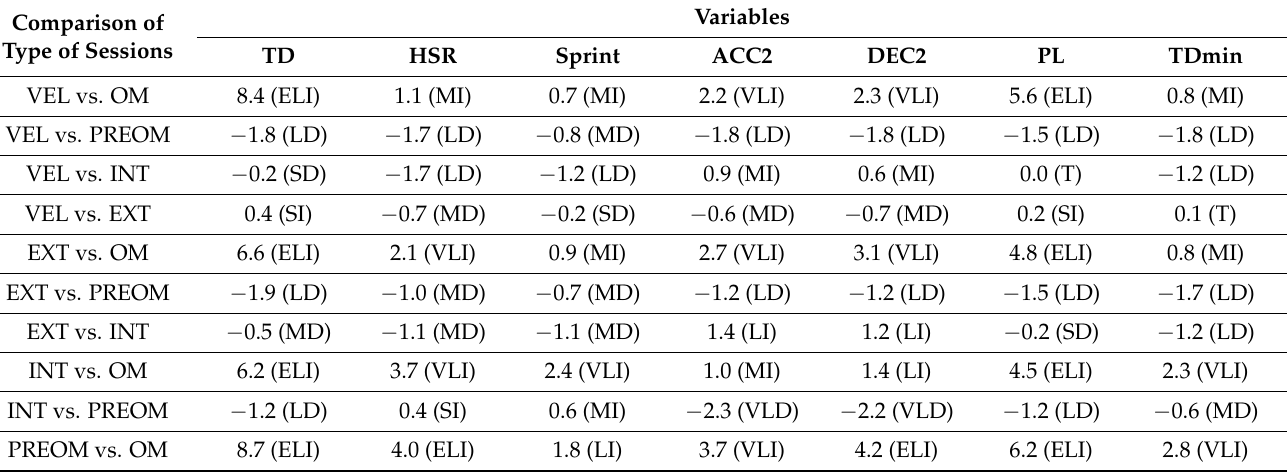
Table 2. Effect size of external load variables in different training and competition sessions.